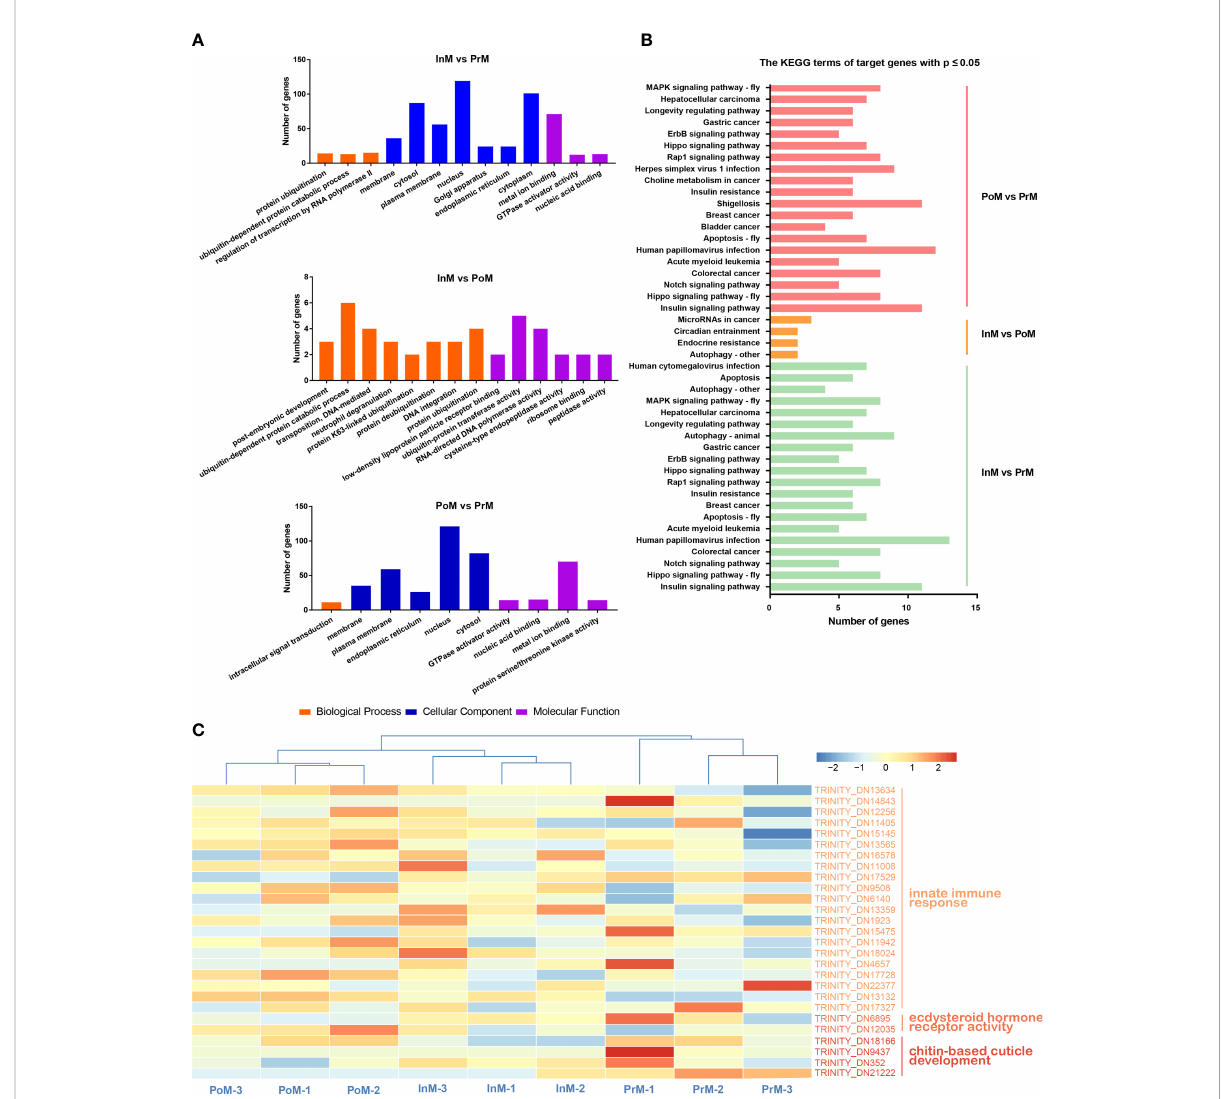
FIGURE 7 Functional enrichment analysis of miRNA target genes and pathways. (A) GO enrichment analysis of miRNA target genes. (B) KEGG enrichment analysis of the miRNA target genes between adjacent molting stages of S. paramamosain. PoM, postmolt; InM, intermolt; PrM, premolt. (C) Heatmap of miRNA target genes involved in innate immune response, ecdysteroid hormone receptor activity and chitin-base cuticle development in molting stages in S. paramamosain . Colored keys represent the log 10 (FPKM+1) of target genes between adjacent molt stages. The red color represents upregulation and the blue color represents downregulation. Each column represents one biological replicate and each row represents a miRNA target